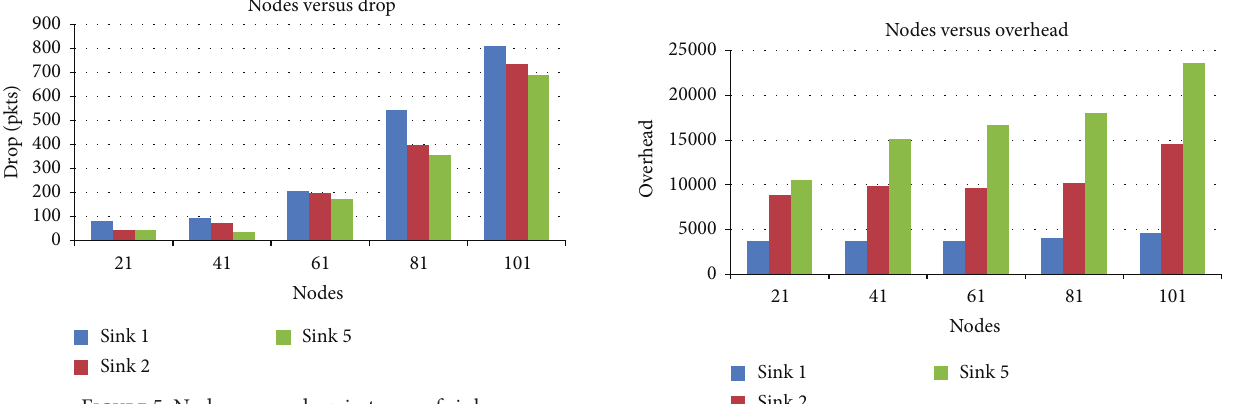
Figure 5: Nodes versus drop in terms of sink.